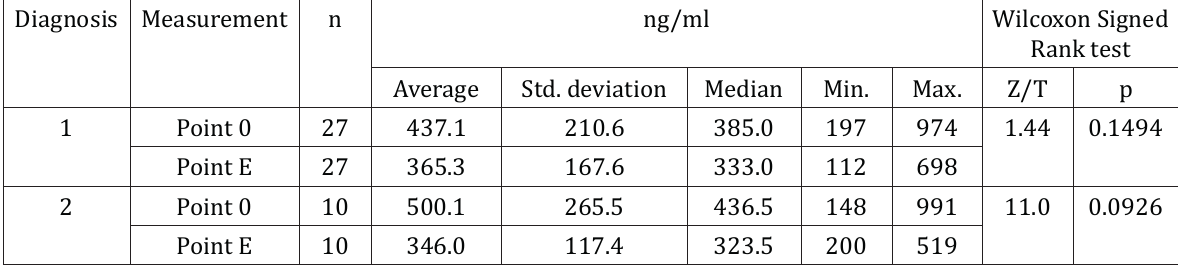
Table 7. Descriptive statistics – Concentration of MMP-9 in patients with differing diagnosis at two points in time and the results of a Wilcoxon Signed Rank test